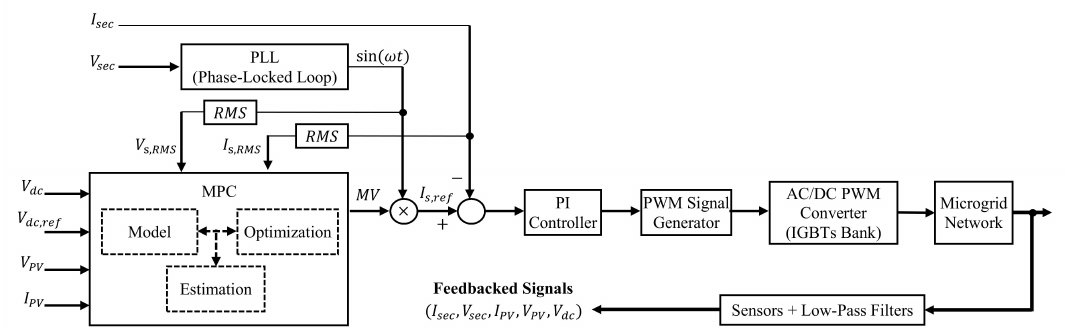
Figure 10. PFTC loop of the AC / DC PWM converter based on model predictive control